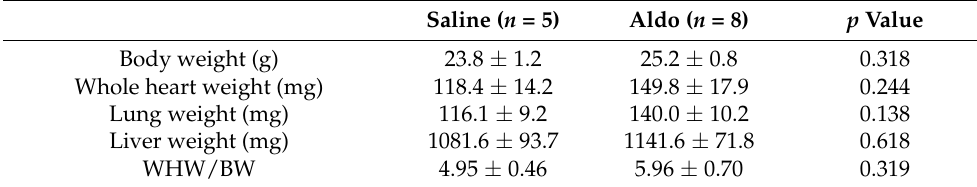
Table 3. Characteristics of mice 1 week after saline and aldosterone